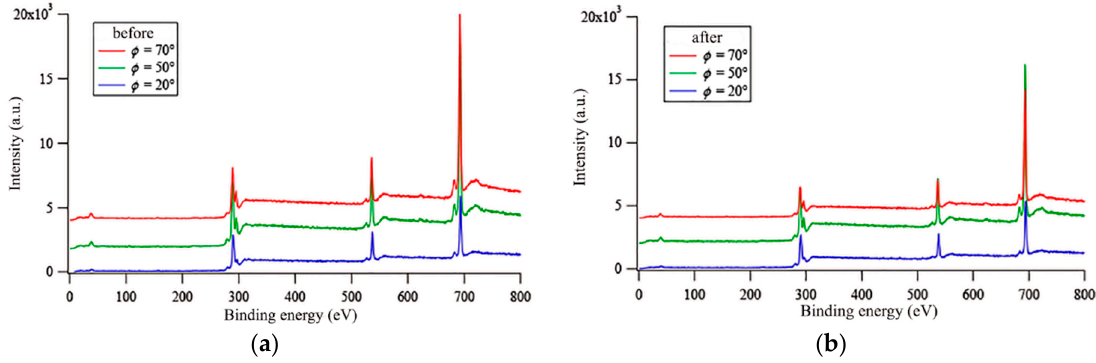
Figure 7. X-ray photoelectron spectroscopy (XPS) survey spectra for E13-S27Sz A 11_100 at three different photoemission angles before ( a ) and after ( b ) 7 days of immersion in water.